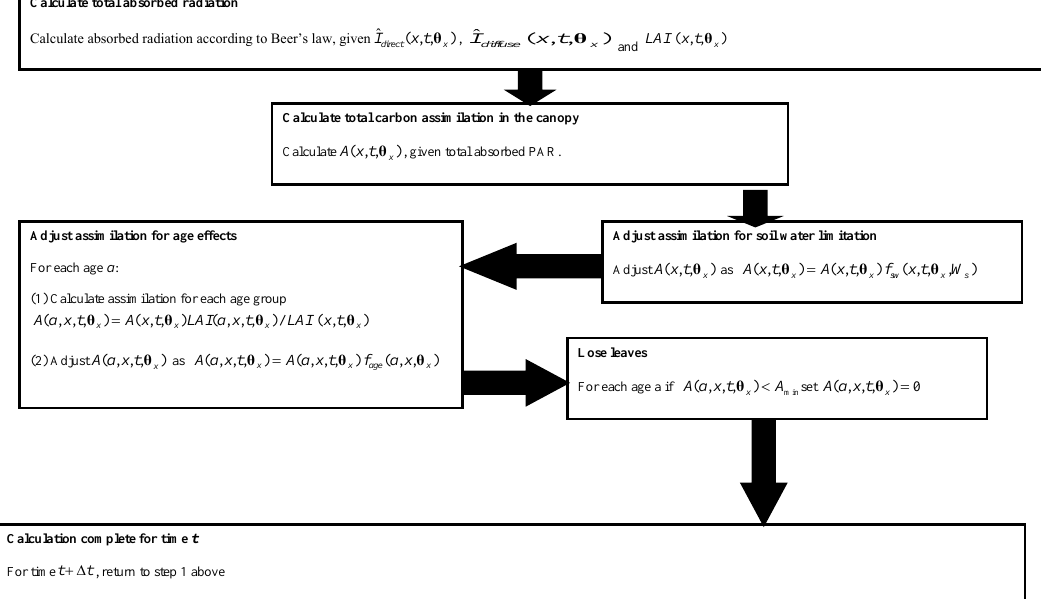
Fig. 1. Model schematic showing how to calculate predicted LAI at time t at a given location x and set of parameters 2 x .